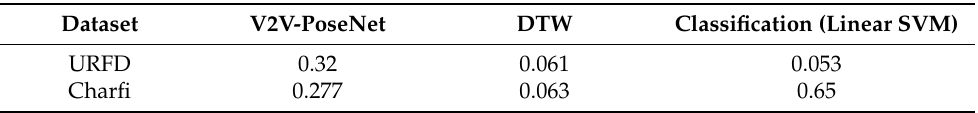
Table 6. Computation time (in seconds) for each step of our algorithm. Computation times were computed separately for the Charfi and URFD